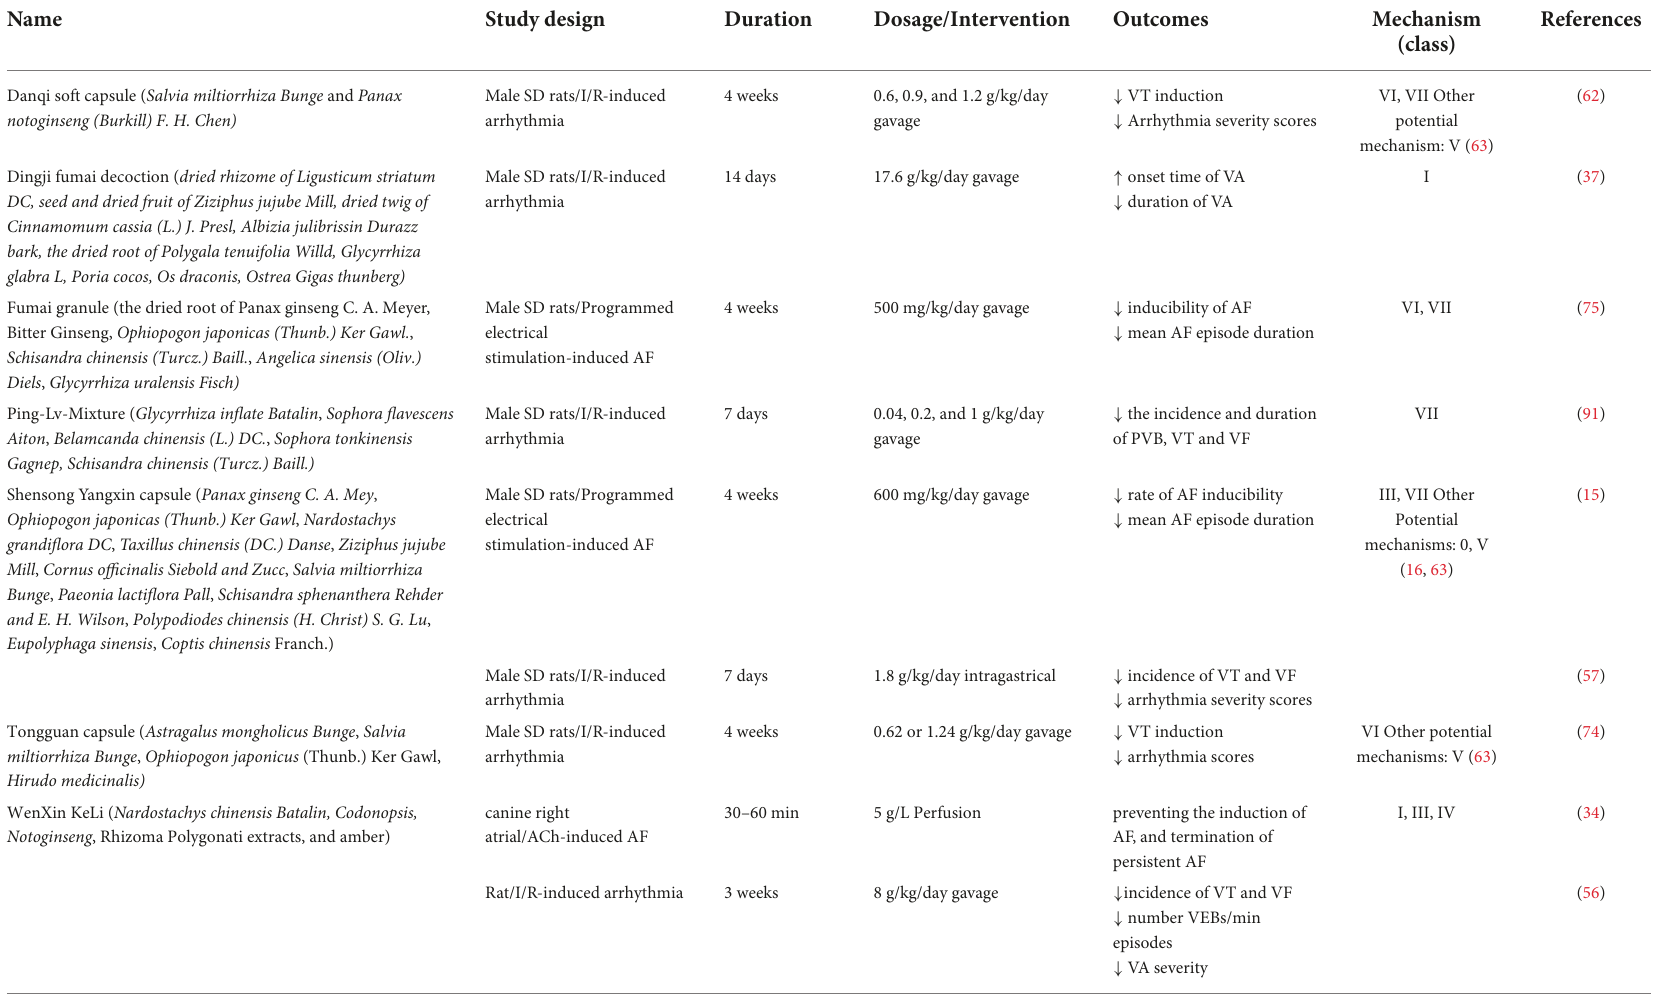
TABLE 2 Multi-component herbal preparations with antiarrhythmic effects and their mechanism of action. Multi-component herbal